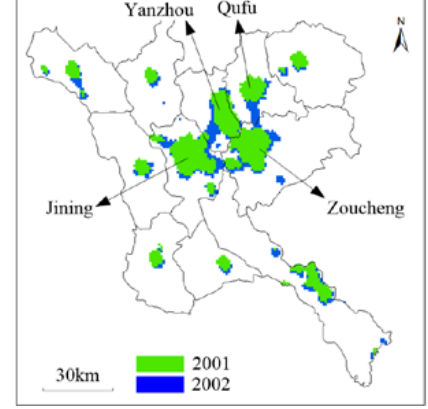
Figure 9. The integration phenomenon of county-level cities in Jining from 2001 to